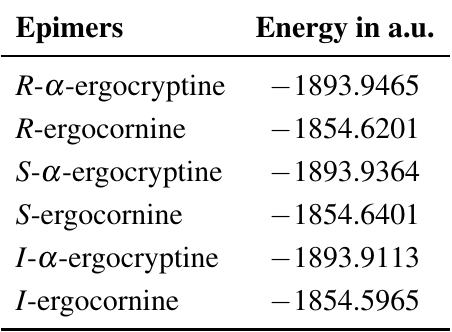
Table 1. The minimum of the quantum chemical potential energy E ergocryptine and ergocornine in the implicit solvent water expressed using atomic units.